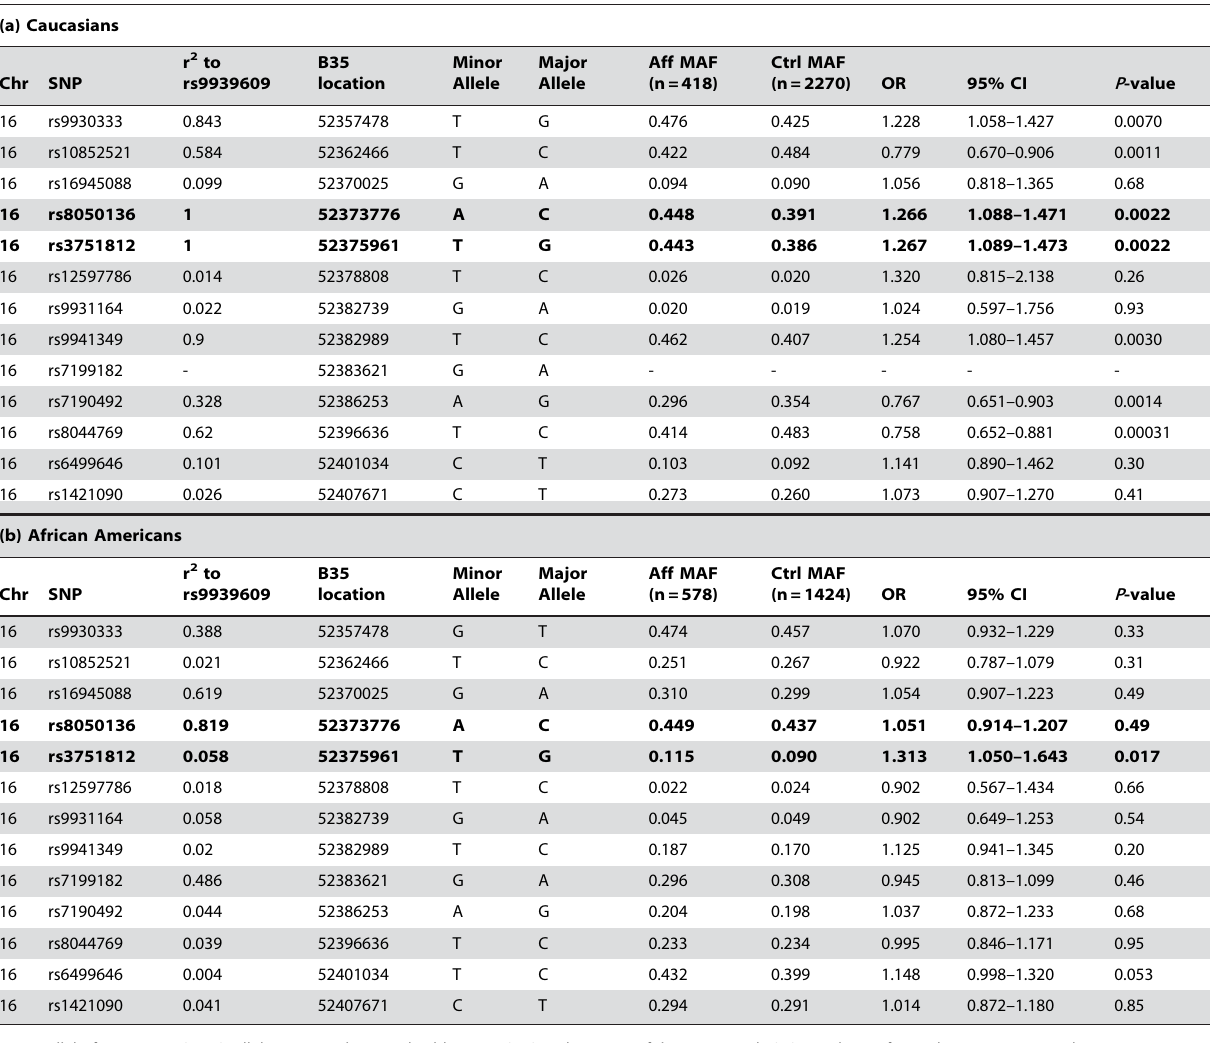
Table 1. Childhood obesity case-control association study results for FTO region markers perfectly correlated with rs9939609 in Caucasians (bold) plus all other markers present on the BeadChip in the corresponding HapMap CEU region of LD in our (a) Caucasian and (b) African American cohorts